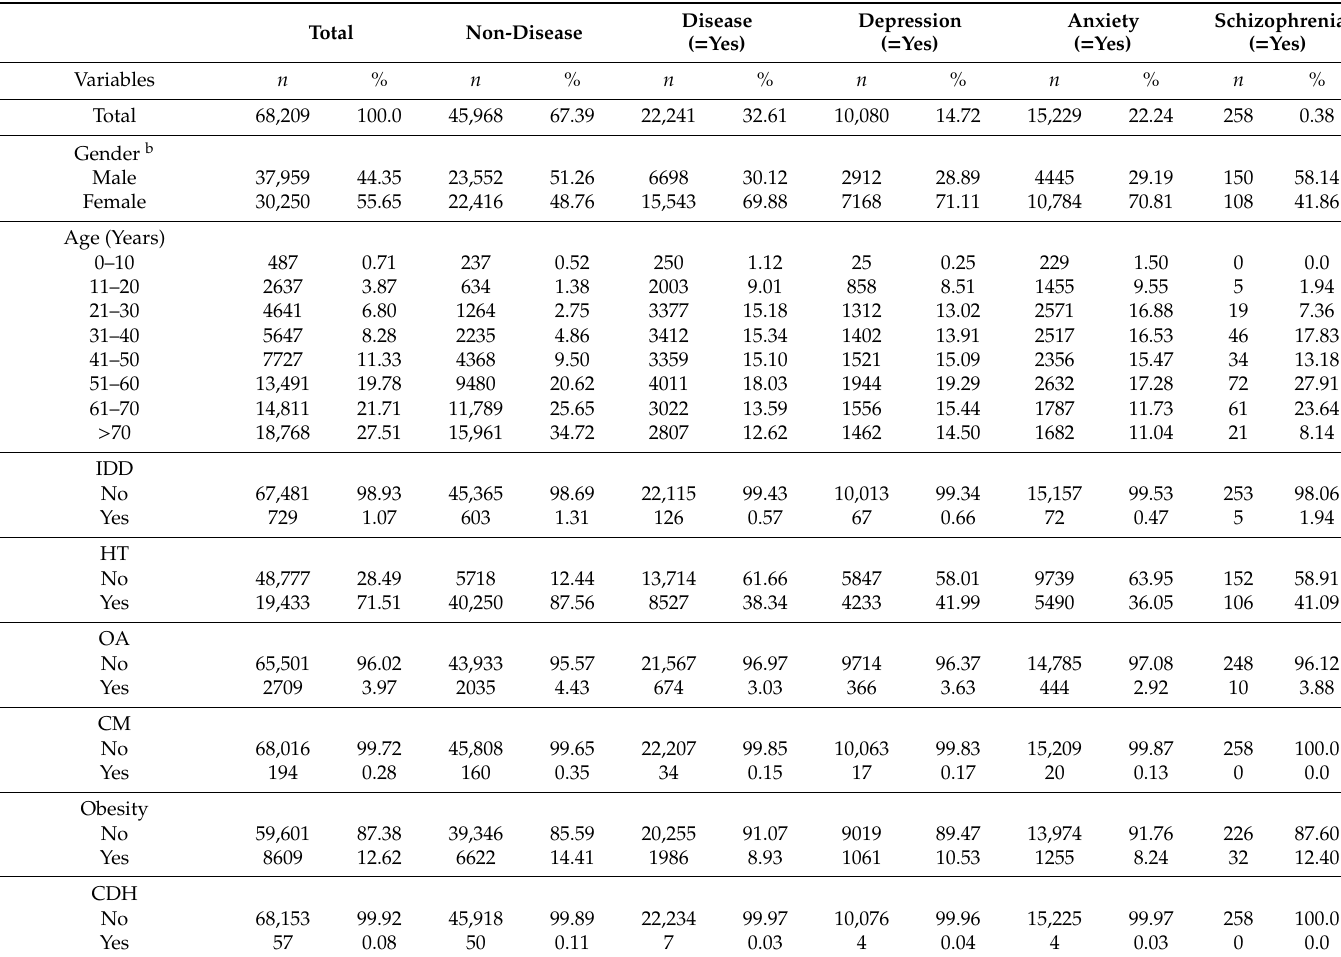
Table 1. Summary of drug usage, dietary supplements, and comorbidities for patients with mental illness a